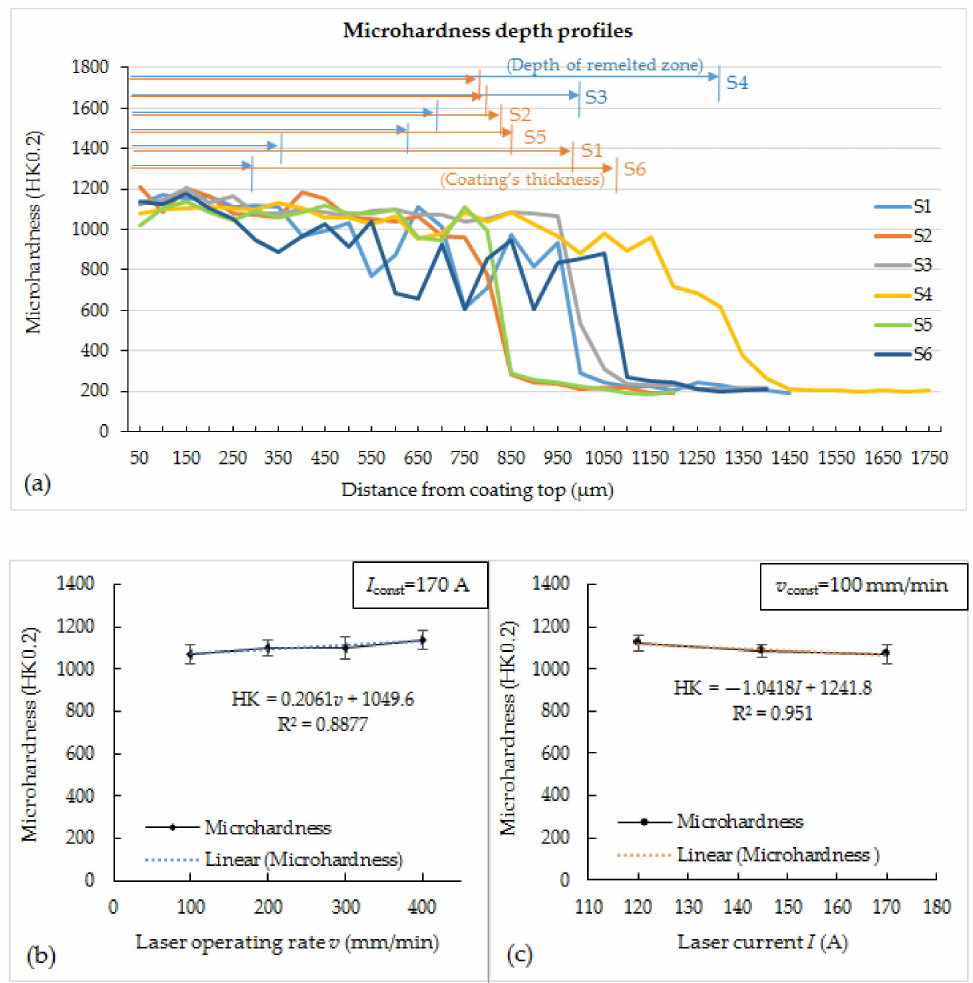
Figure 7. Microhardness depth profiles of the coatings ( a ) and dependencies of the average micro- hardness of remelted zones on the laser operating rate at a constant current 170 A ( b ) and laser current at a constant operating rate 100 mm/min ( c